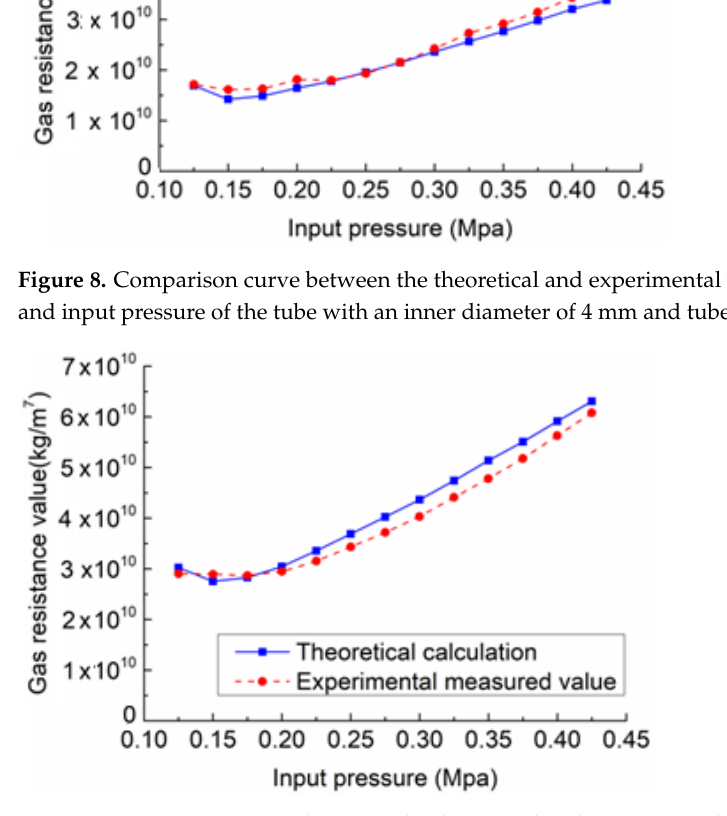
Figure 9. Comparison curve between the theoretical and experimental values of the gas resistance and input pressure of the tube with an inner diameter of 4 mm and length of 1.0 m.